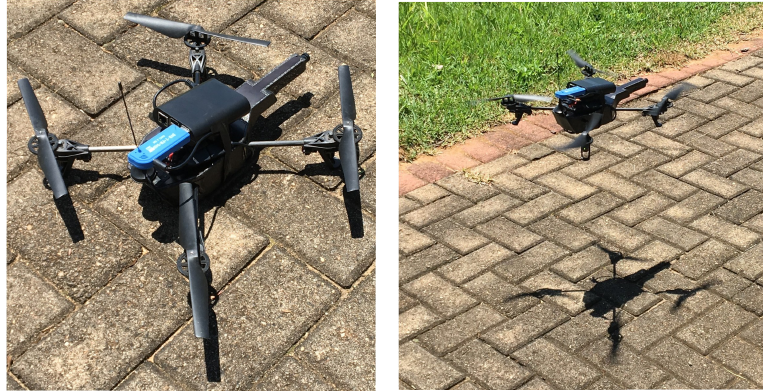
Figure 8. The CR-based UAV prototype developed for this work.